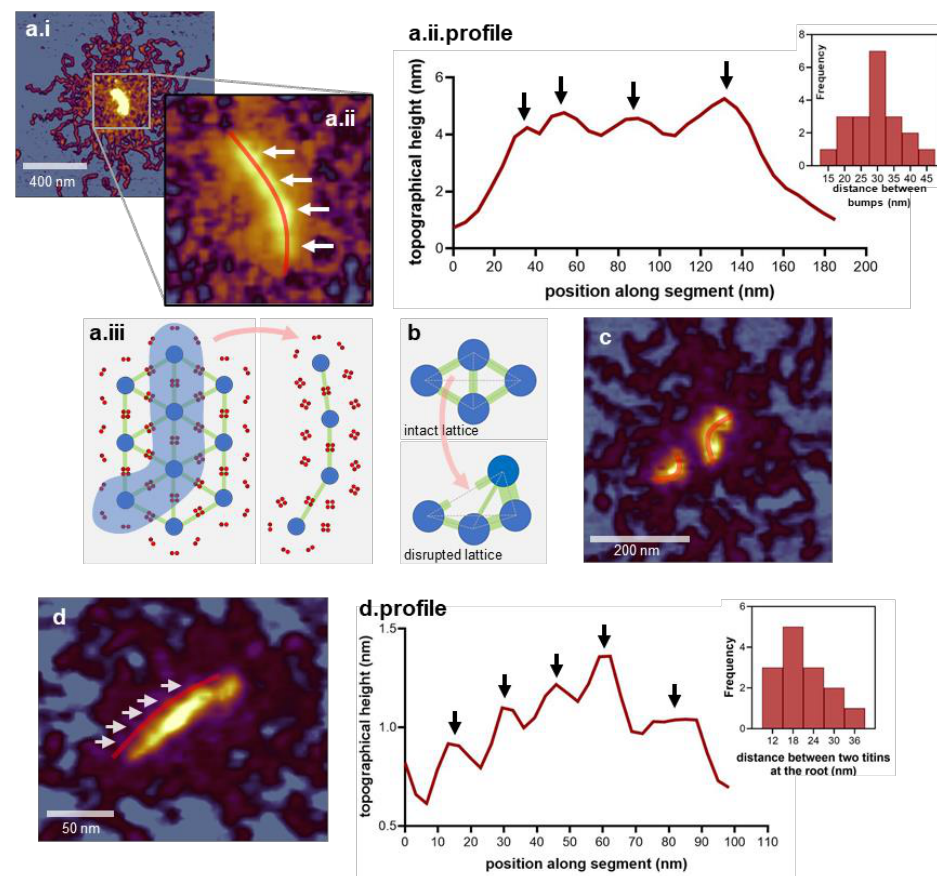
Figure 2. Supramolecular architecture of the M-complex. ( a.i. ) Height-contrast AFM image of a large titin oligomer displaying an array-like M-complex. ( a.ii ). Enlarged view of the M-complex array. Arrows point at the topographical “bumps” identified as individual M-complexes. The red line running through the center of the M-complexes marks the section along which a topographical profile was obtained. ( a.ii.profile ). Topographical height profile along the M-complex array. Arrows mark the topographical peaks corresponding to M-complex centers. ( Inset ), distribution of distance between neighboring height peaks in the M-complex array. ( a.iii ). Schematic model of obtaining the M-complex array. Part of the sarcomeric M-band lattice, highlighted with light blue, is preserved during purification. Dark blue: myosin thick filaments in cross-section; green: M-bridges containing myomesin; red: two pairs of titins from each side of the sarcomere. ( b ). Schematic model of the mechanical disruption of the M-band lattice leading to a wide distribution of the distance between neighboring M-complexes. The thickness of the interconnecting green lines indicates the contractile state of the M-bridges (i.e., thick: contracted; thin: extended). ( c ). AFM image of an M-complex array dissociated into subunits. ( d ). AFM image of an M-complex array. Arrows point at the titin filaments entering the M-complex array. The red line marks the section along which a topographical profile was obtained. ( d.profile ). Topographical profile plot along the titin filaments entering the M-complex array. Arrows mark the topographical peaks corresponding to the titin filament axes. ( Inset ) shows the distribution of distance between neighboring topographical